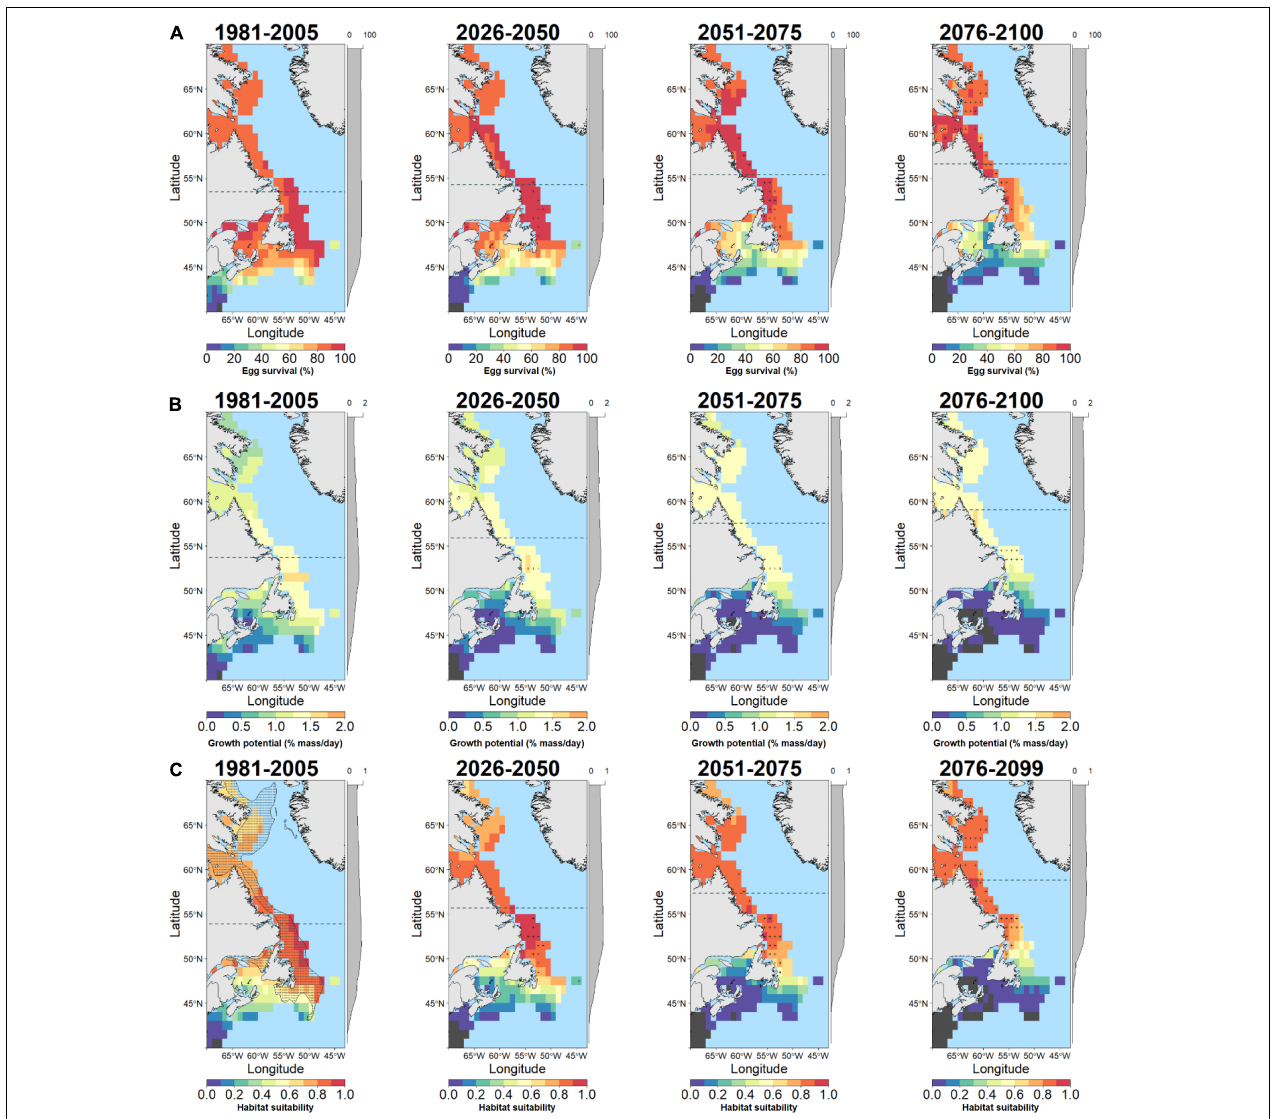
FIGURE 2 | Baseline and future projections of habitat suitability for Polar cod ( B. saida ) based on temperature-dependent egg survival (A) , temperature-dependent juvenile growth potential (B) , and geometric means of combined egg and juvenile habitat suitability (C) . Dark gray cells indicate zero values while cells with high uncertainty (small change relative to spread across models) are indicated by a (+) symbol. The latitudinal component of the distribution centroid is denoted by a dashed gray line across each plot. Marginal plots along the y -axis show the mean cell values across latitude. The current distribution of B. saida is shown on the baseline habitat suitability (stippled area; bottom left